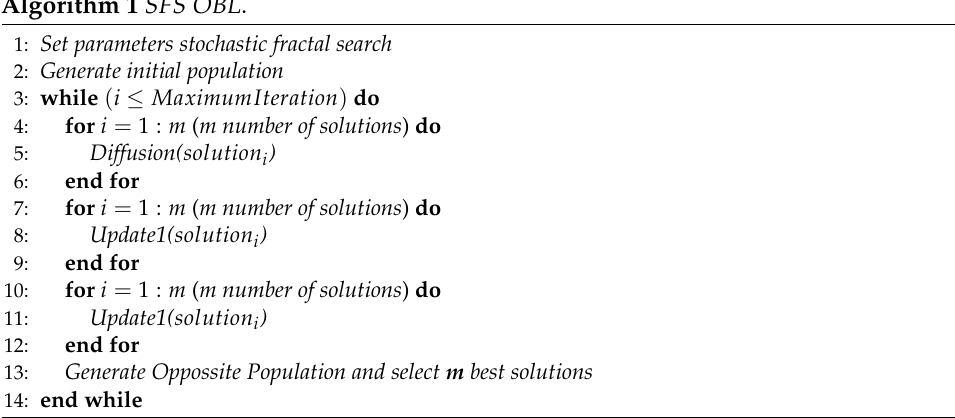
Algorithm 1 SFS OBL .